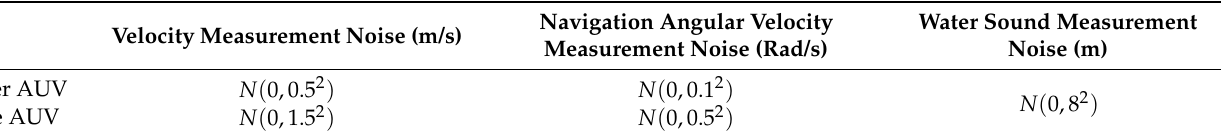
Table 5. Parameters related to the navigation simulation tests.